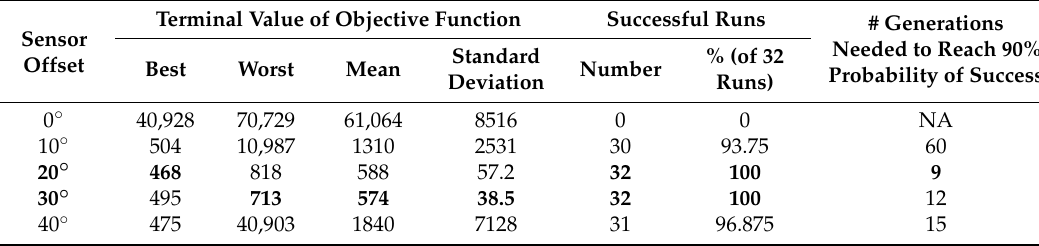
Table 3. Efficiency of evolution of the team of predator agents.